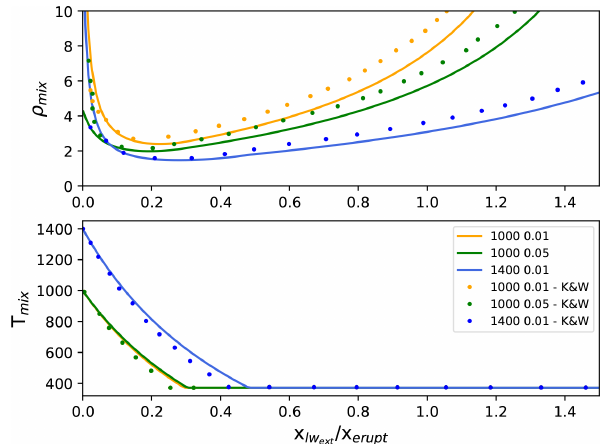
Figure C4. Variation of initial mixture density ( ρ mix ) and temper- ature ( T mix ) as the mass of water added to the magma increases. Continuous lines show the results of PLUME-MoM, while dotted lines are digitized from Koyaguchi and Woods (1996). Curves are shown for initial magma temperatures of 1000 and 1400K, while magma volatile content ranges from 0.01 to 0.05wt